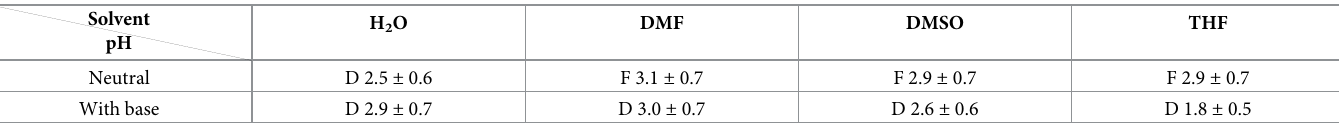
Table 2. Fo¨rster distance in nm of the DCCH and FTSC pair in dependence of solvent and pH value. The D and the F in the Table represent whether DCCH or FTSC took the role of the Donor in the combination, respectively. The other molecule was the acceptor. Solvent pH Neutral With